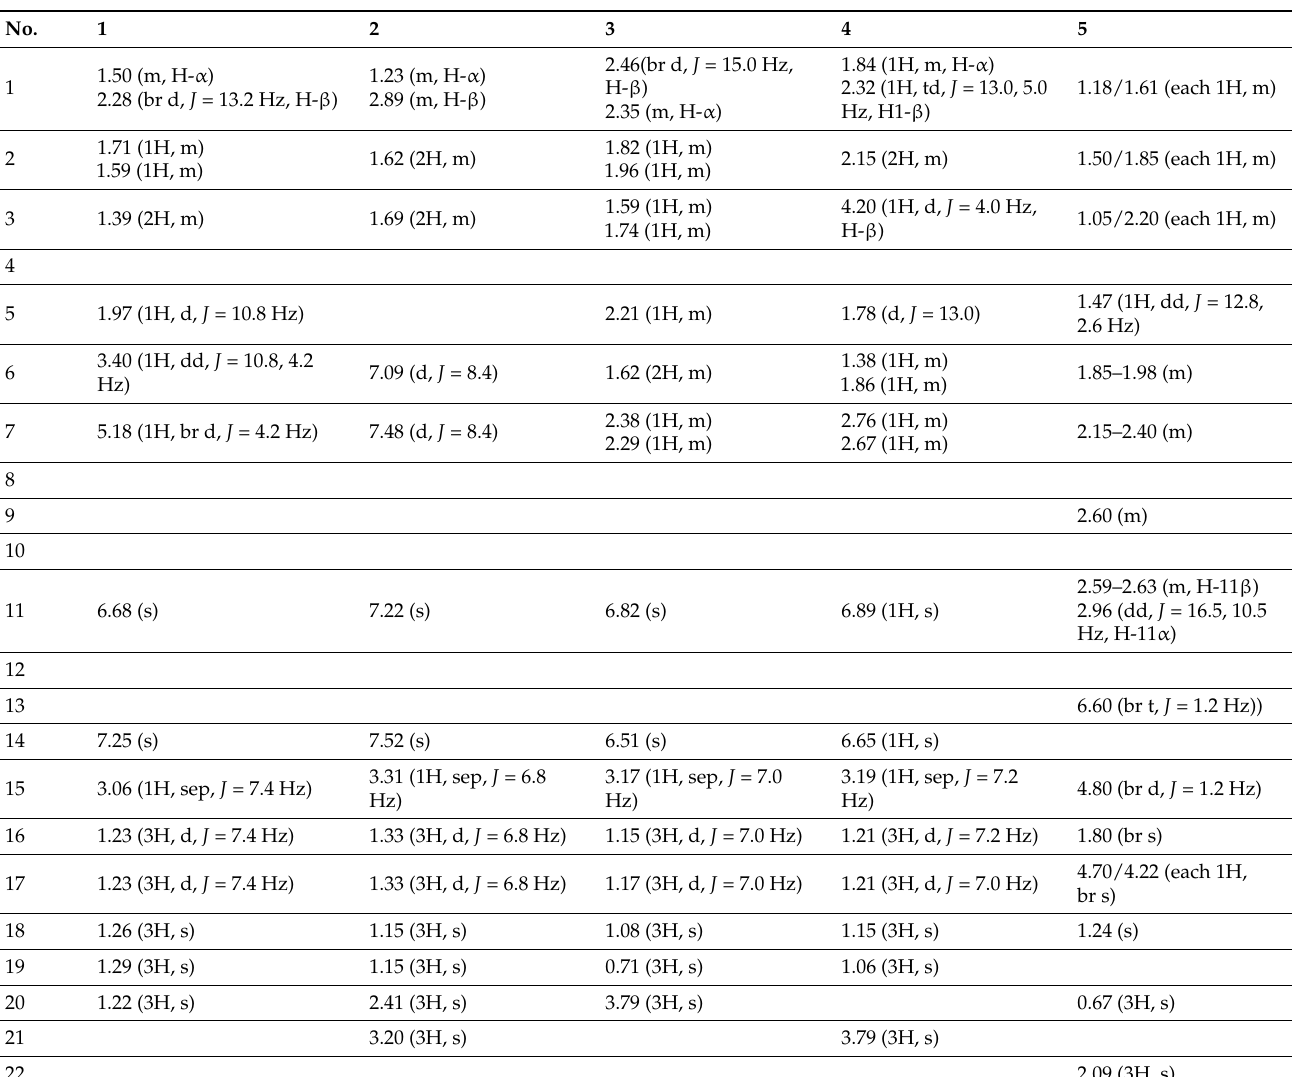
Table 2. 1 H-NMR data for Compounds 1 – 5 in CDCl 3 ( δ in ppm, J in Hz, and 600 MHz in CDCl 3